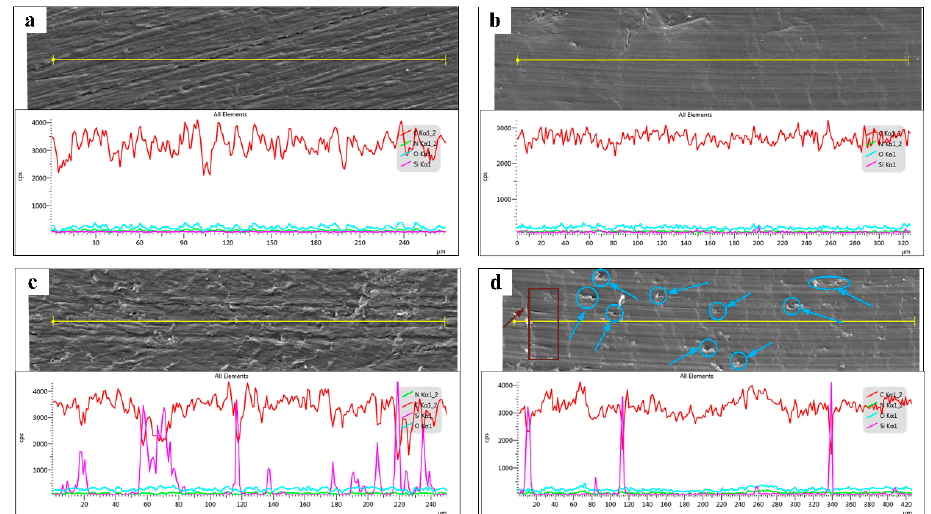
Figure 12. The SEM images and corresponding line scanning EDS analysis for the polished speci- mens. ( a ) Outside of wear tracks for Pure PA 12 specimens. ( b ) Inside of wear tracks for Pure PA 12 specimens. ( c ) Outside of wear tracks for SiC/PA12 composite specimens. ( d ) Inside of wear tracks for SiC/PA12 composite specimens.